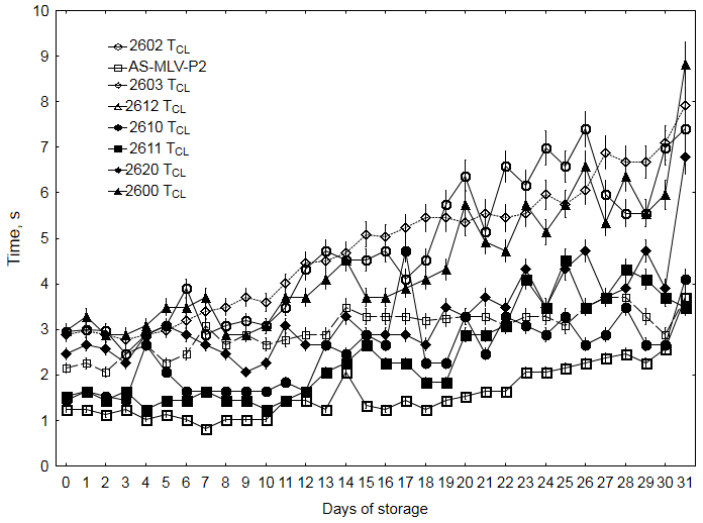
Figure 4. Cleaning time ( T CL ) of rapeseed during 31 days of storage.